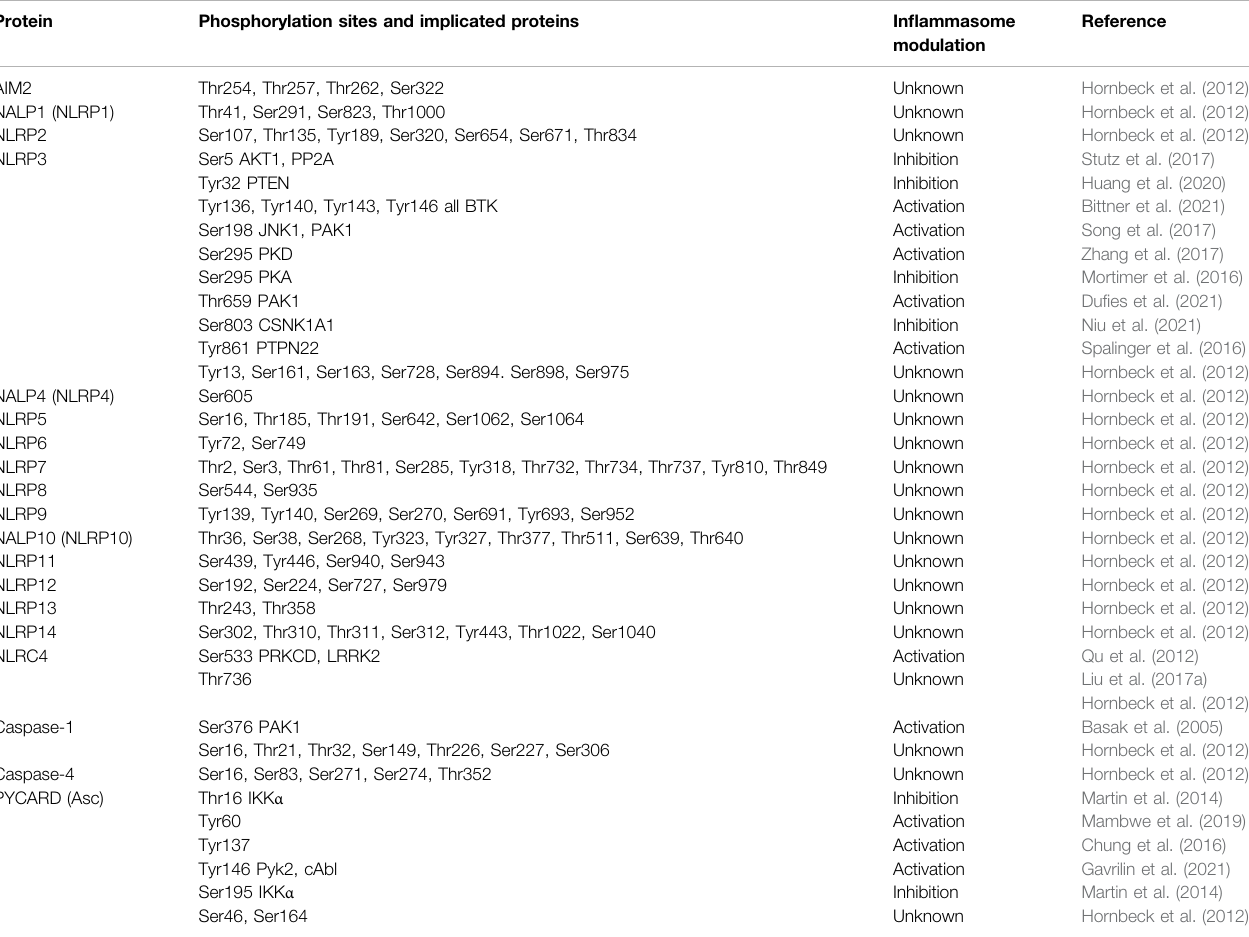
TABLE 1 | Summary of human in fl ammasome phosphorylation. Phosphorylation sites which have been functionally validated are highlighted in green, whereas non- characterized sites found in the PhosphositePlus are depicted in orange (data retrieved from PhosphositePlus, v6.6.0.4 in April 2022).